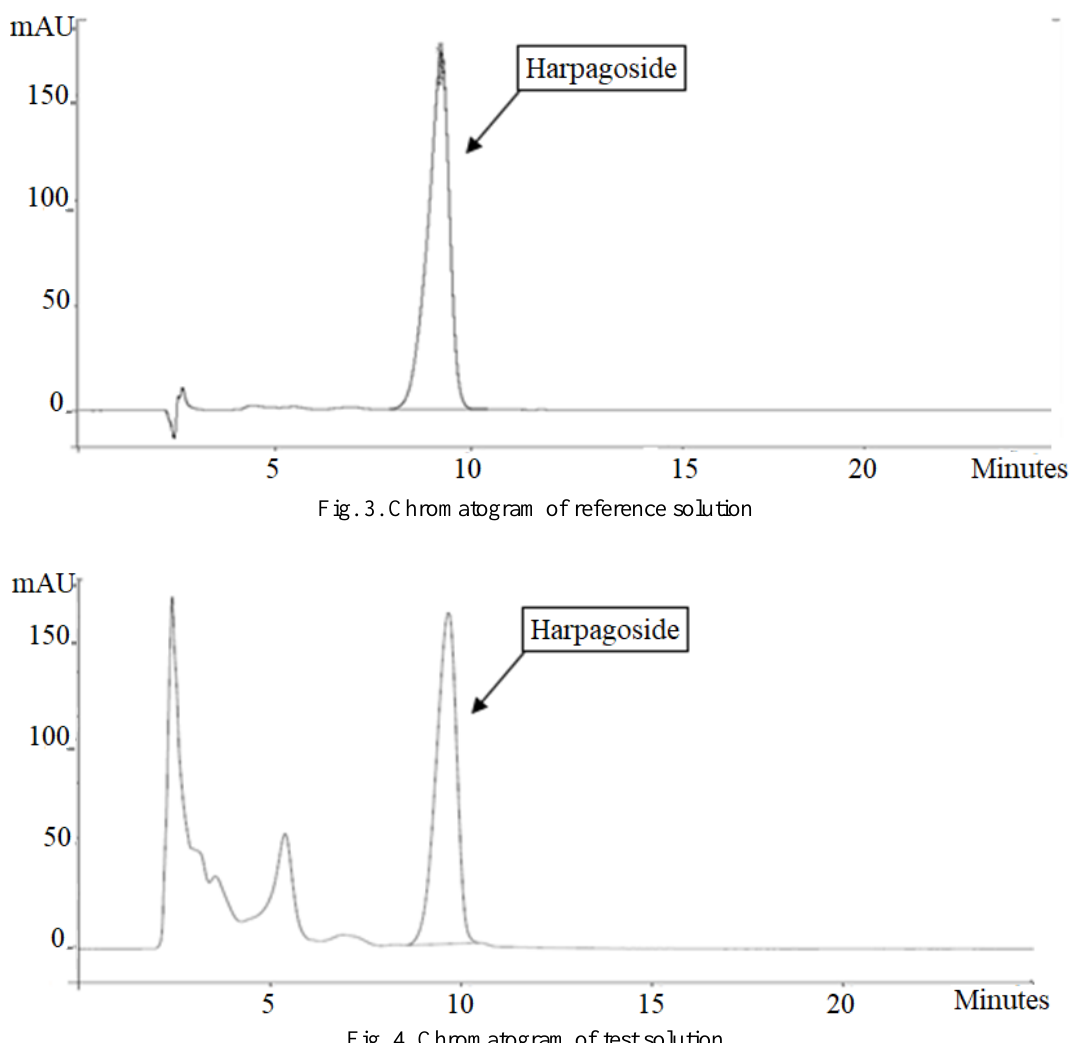
Fig. 4. Chromatogram of test